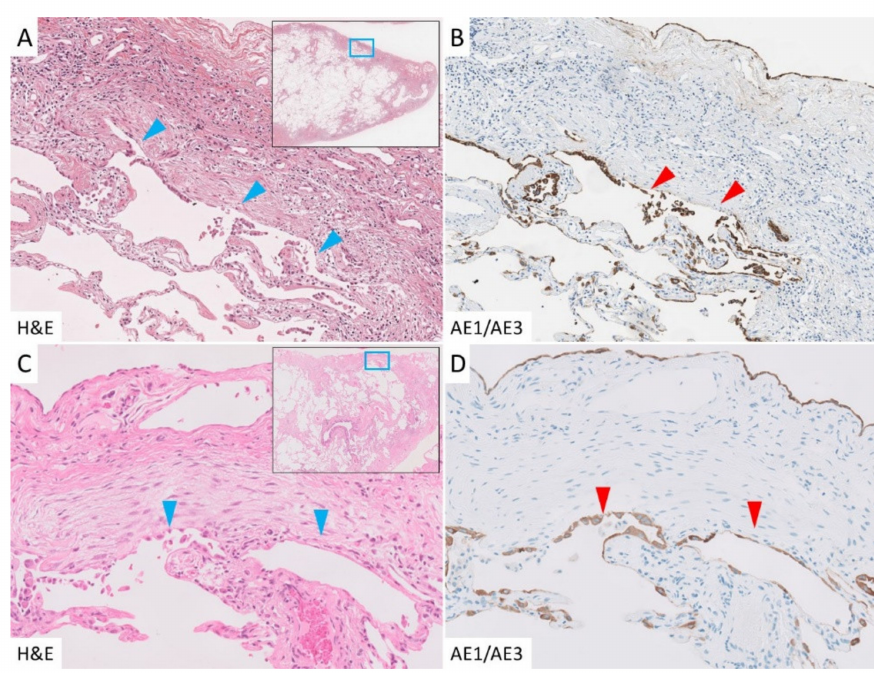
Figure 4. Epithelial denudation in the IPF group. ( A,B ): Dense fibrosis and abrupt changes in the normal lung were seen, with noticeable AED in those areas (arrowhead). ( C,D ): Fibroblastic foci were well observed, some of which were also accompanied by AED, but most were covered with regenerating epithelium